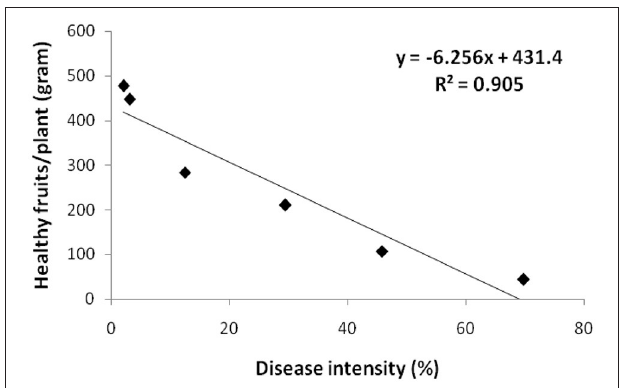
FIGURE 2 | Relationship between disease intensity with the weight of healthy fruits per plant on chili pepper cultivar Cabe Besar